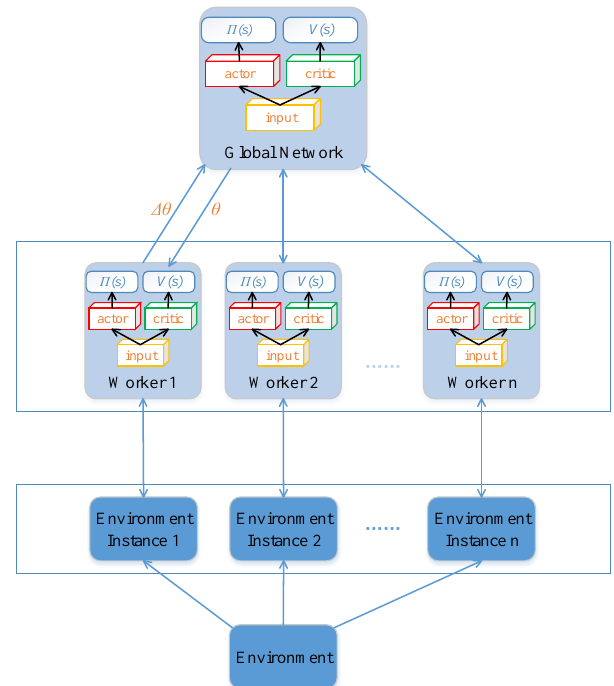
Figure 4. The flowchart of Asynchronous Advantage Actor-Critic (A3C).